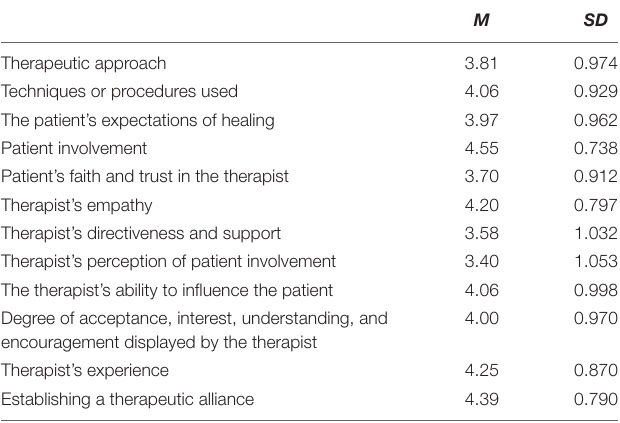
TABLE 2 | Mean assessments of the psychotherapeutic